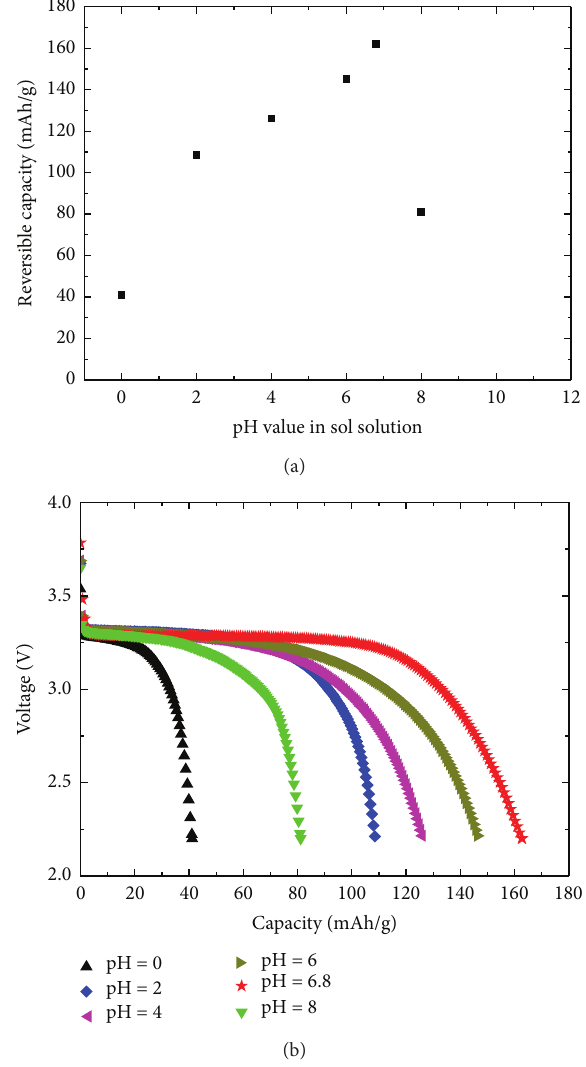
Figure 3: (a) The reversible capacity as a function of pH value in the precursorenvironment;(b)dischargeprofileofLiFePO 4 synthesized at the different pH precursor